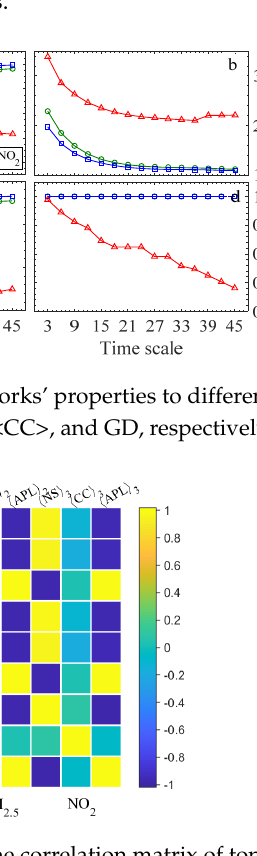
Figure 6. Diagram for the correlation matrix of topological parameters. The subscripts 1, 2, and 3 of the three parameters represent AQI, PM 2.5 , and NO 2 , respectively.